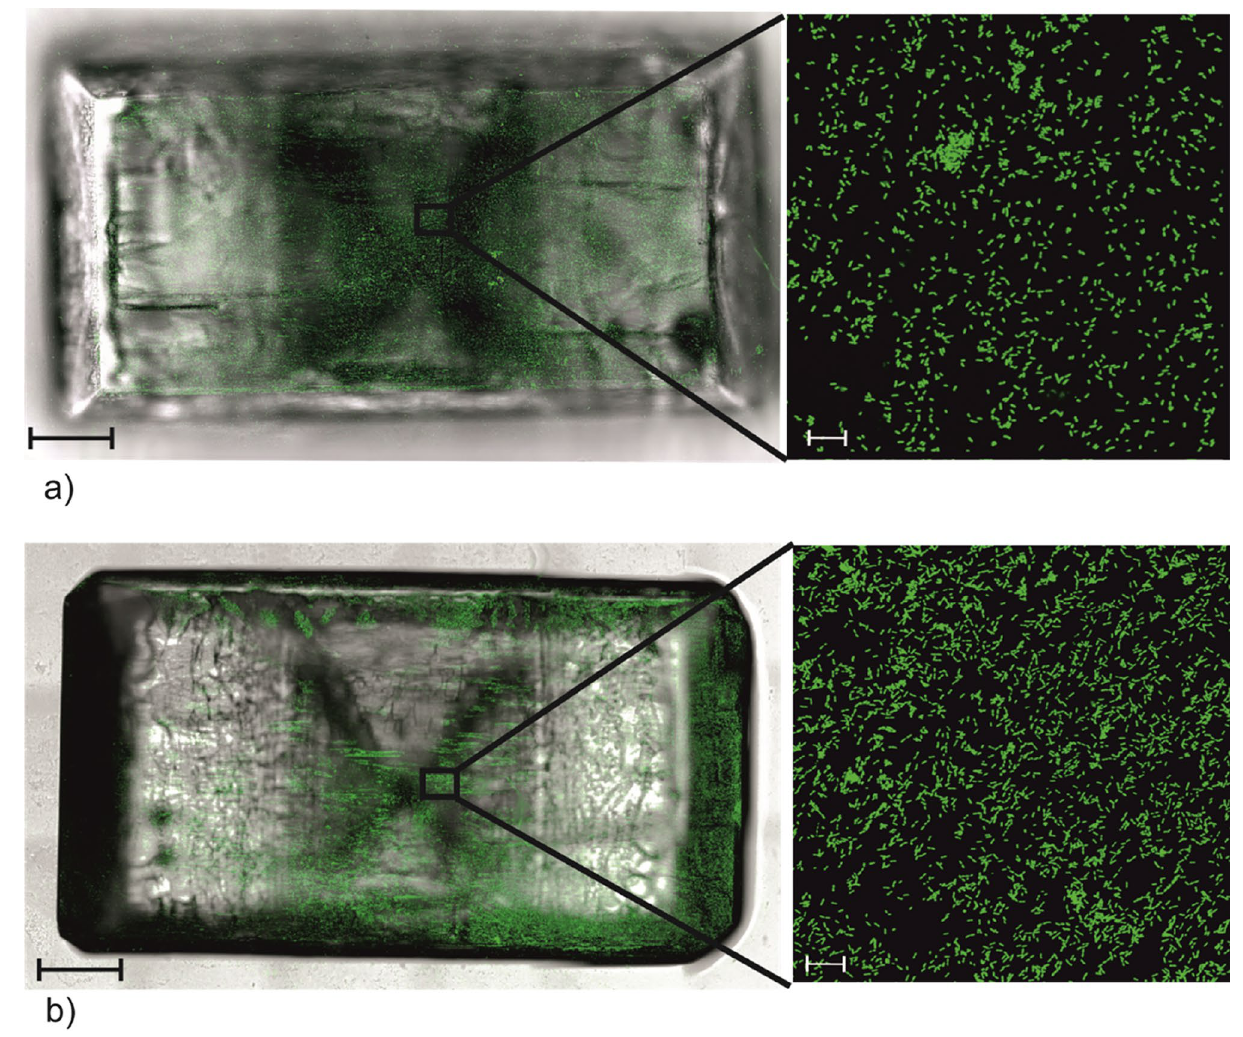
Figure 5. Confocal microscopic observation of Proteus mirabilis adhesion to the crystal surface after Syto-13 staining. ( a ) top face (001); ( b ) bottom face (00 1 ). On the left, a view of the entire face—scale bar 500 µm (a fluorescence image superimposed with a transmitted light image), on the right, a selected part of the surface, scale bar 20